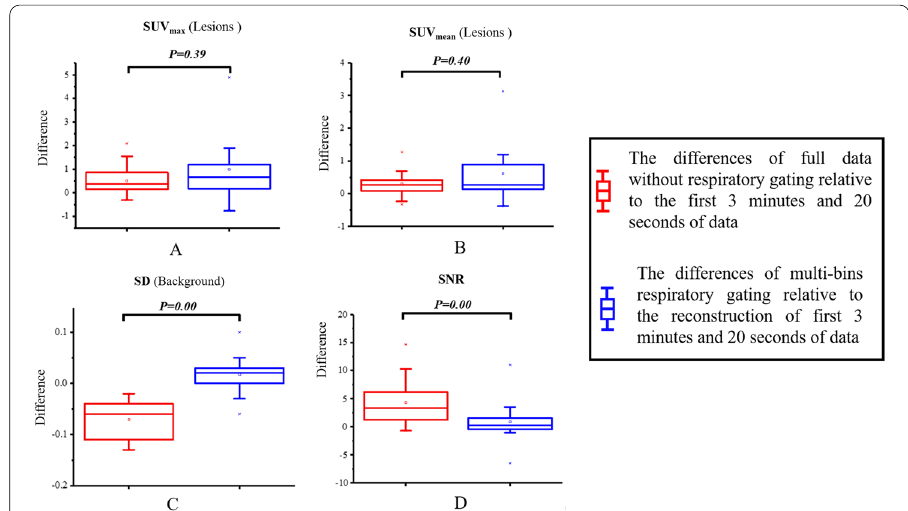
Fig. 3 Comparison of difference among the reconstruction of full data without respiratory gating relative to the reconstruction of the first 3 min and 20 s of data (red boxes), the reconstruction of multi-bins respiratory gating relative to the reconstruction of first 3 min and 20 s of data (blue boxes), for four parameters, the SUV max ( A ) and SUV mean ( B ) of lesions, the standard deviation of background ( C ) and SNR ( D ). The corresponding statistical results were also